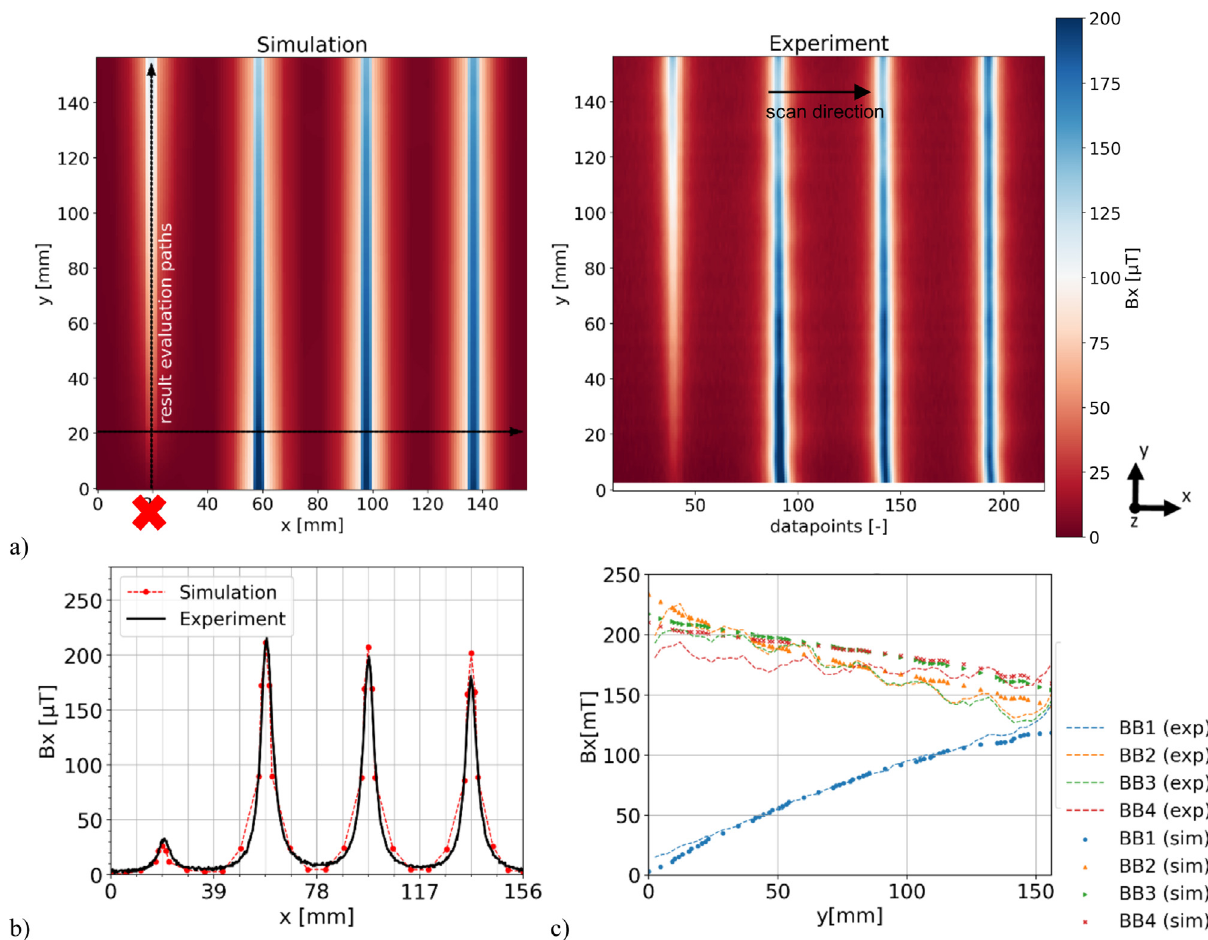
Fig. 5. X-component of the magnetic fi eld of a solar cell with a defect fi rst busbar as heatmaps (a) as a lineplot perpendicular to (b) and along (c) the busbars comparing the simulation and the experiment.